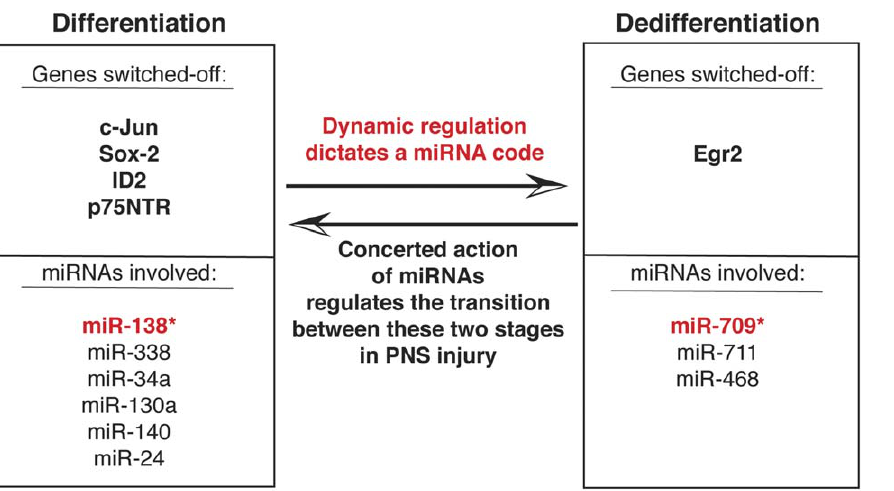
Figure 6. Schematic representation of our proposed model regarding the existence of a miRNA code, which regulates the transition between differentiation and dedifferentiation following invivo PNS injury. The synchronous and concerted binding of miRNAs generates a unique code, which is dynamically regulated and affects the expression of the genes that modulate injury response in the PNS (e.g. c-Jun, Sox-2, Egr2).